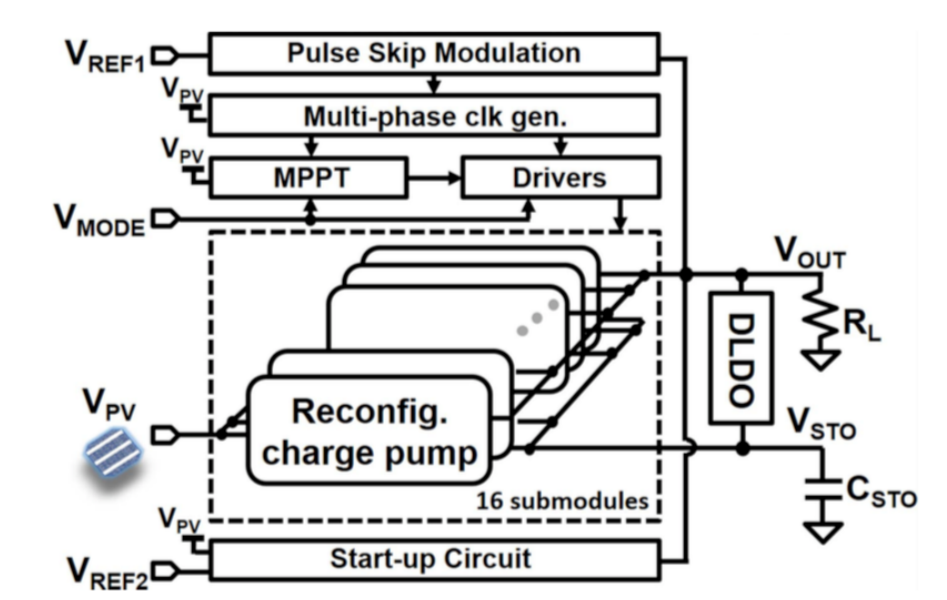
Figure 17. The concept schematic of the converter for indoor light presented in [39].